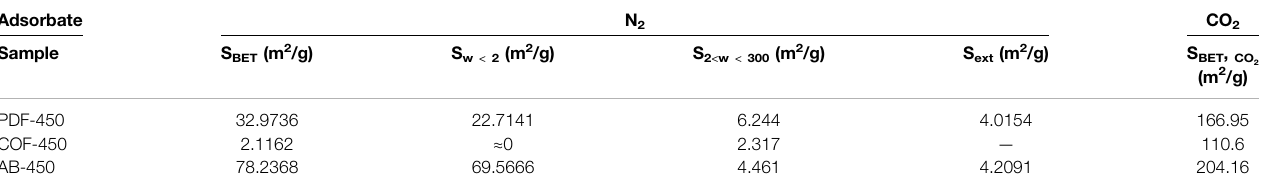
TABLE 3 | Summary of the speci fi c surface areas. The BET speci fi c surface area (S BET ), the speci fi c surface area (S w < 2 ) correlated to micropores (pore width < 2 nm) as calculatedbythet-plotmethod,thespeci fi csurfaceareaS 2 < w < 300 ofthemeso-andmacroporesascalculatedfromtheBarrett – Joyner – Halenda(BJH)methodandthe external surface area (S ex t) obtained from the N 2 adsorption isotherms. The speci fi c surface area S BET , CO biochars were pyrolyzed at 450 ° C.